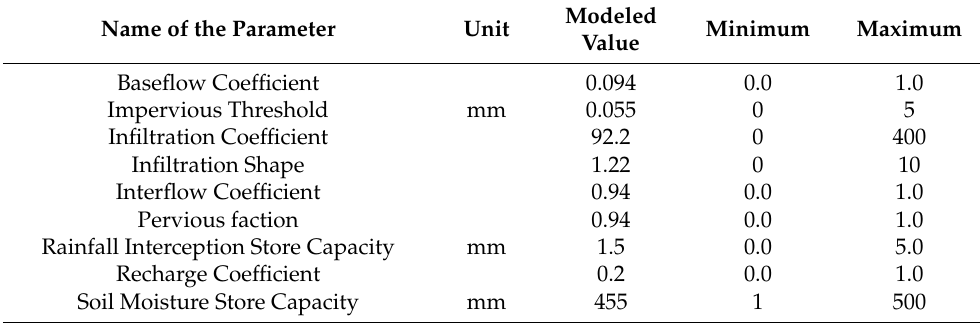
Table 3. The default parameters applied in the SIMHYD modeling with their boundary values.